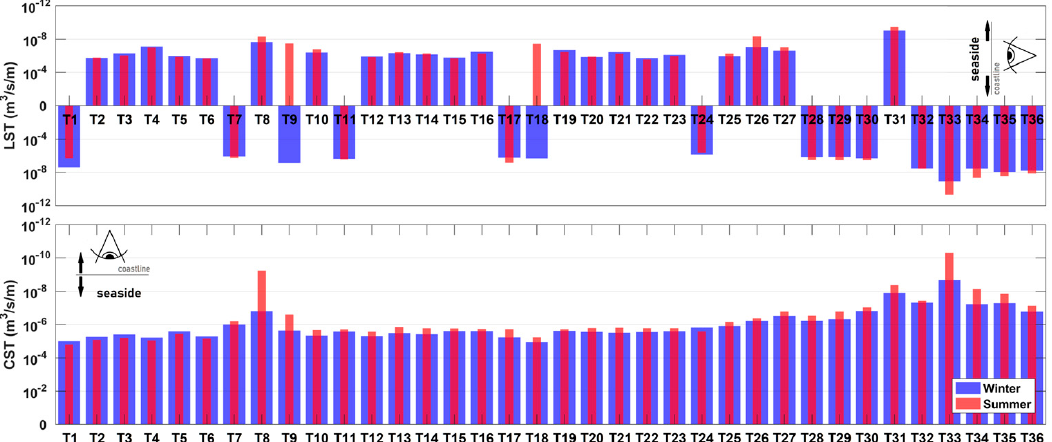
Figure 18. Longshore and cross-shore sediment transport. Each bar corresponds to the mean sediment transport in the profiles indicated in Figures